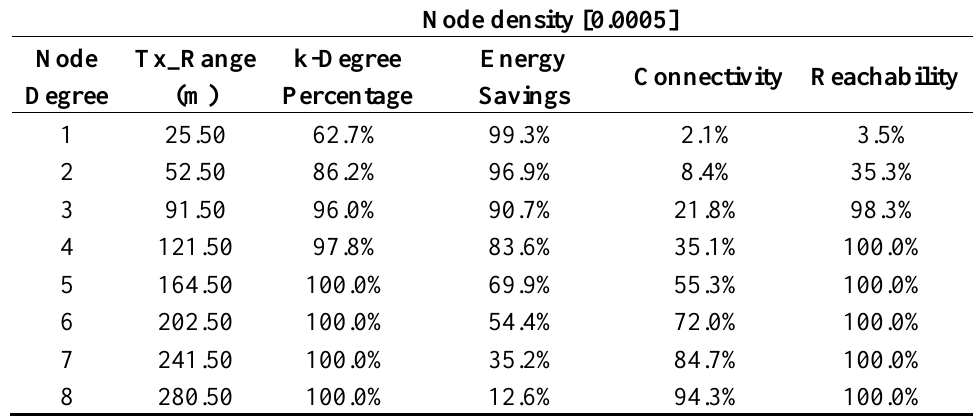
Table 1. The numerical evaluation results for a network with a node density of 0.0005 nodes/m 2